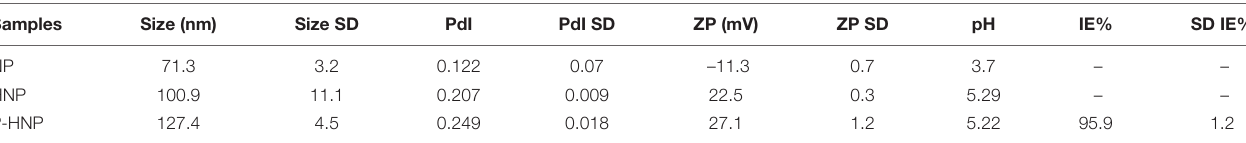
TABLE 1 | Values of size, polydispersity index (PdI), zeta potential (ZP), pH of the formulations NP , HNP , and percentage of immobilization efficiency (%IE) of P-HNP .